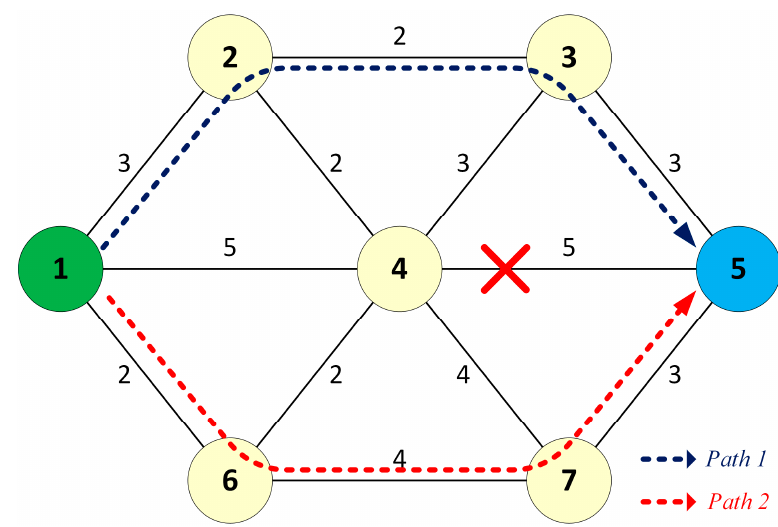
Figure 4. Path recovery in the failure case.